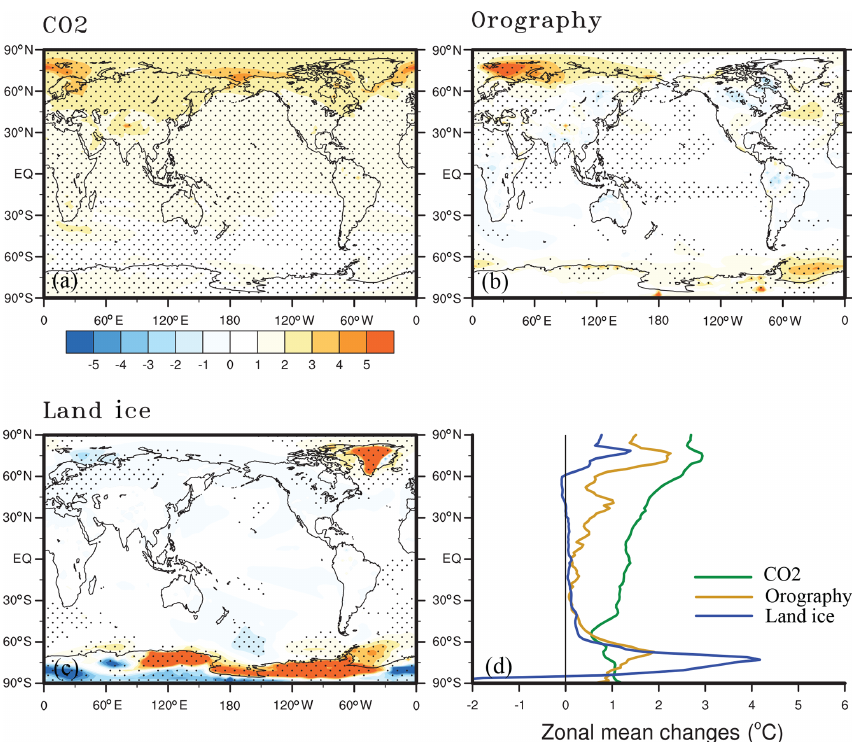
Figure 9. The relative contribution of various boundary conditions ( a CO 2 , b orography, c land ice) to the warmth of PlioMIP 2 and their zonal mean values (d) . Stippling indicates regions where results are statistically significant at 99% confidence criteria.